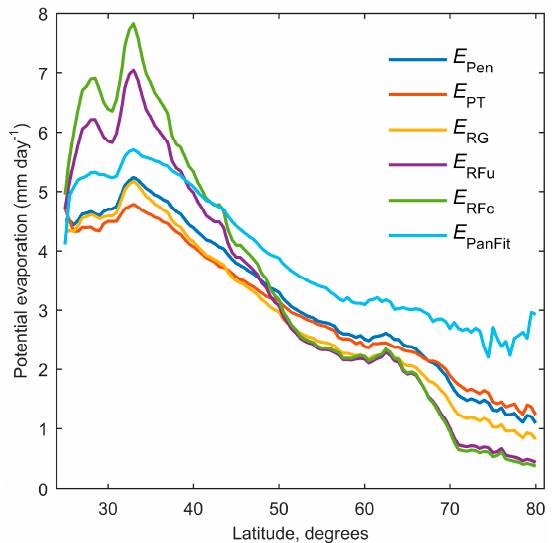
Figure 7. Zonal mean warm-season (May–September) potential evaporation from various models over the land surface of North America. Table 3. Ecozone-average mean warm-season (May–September) variables over the period 1951–2014: